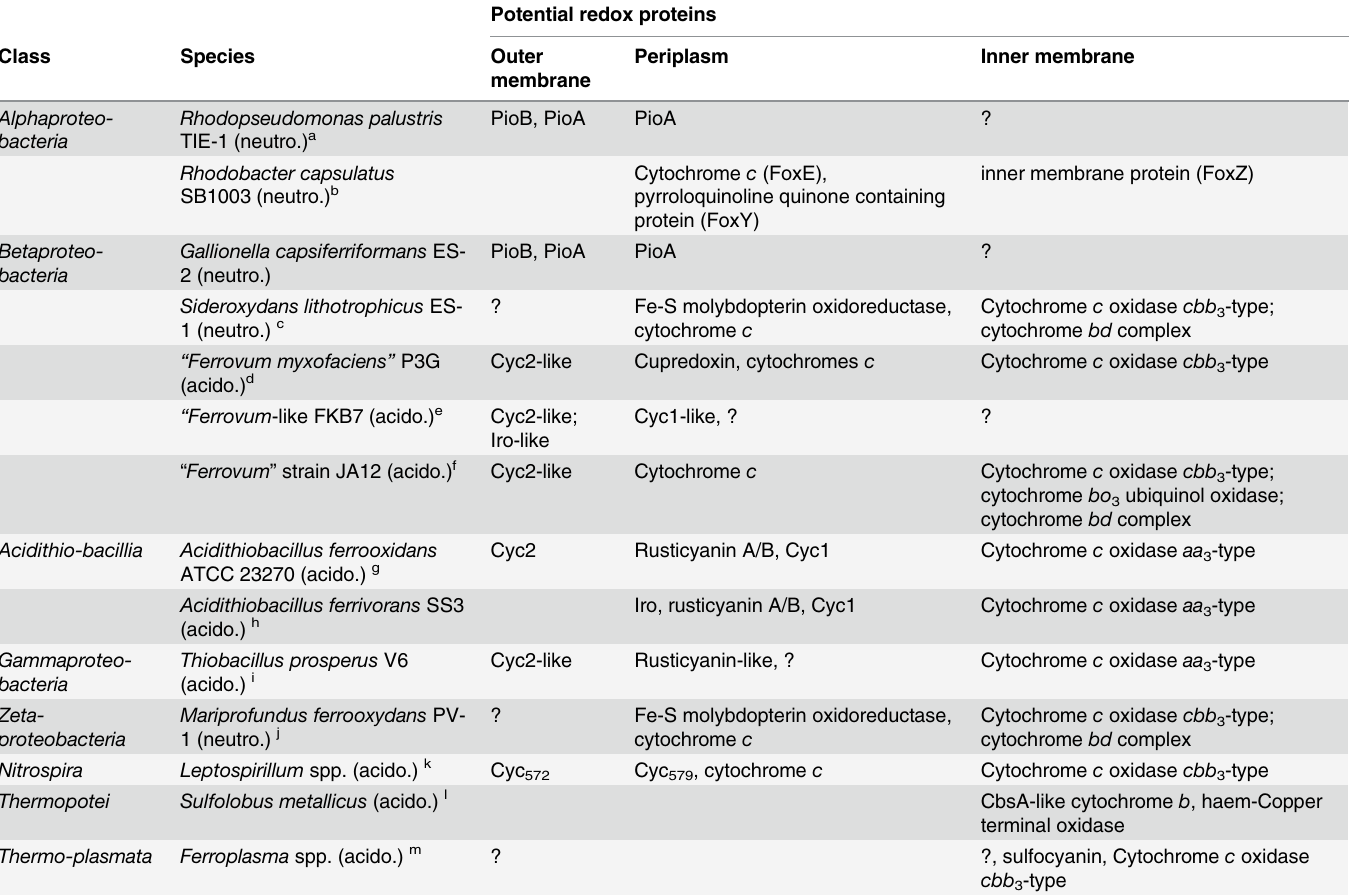
Table 2. Redox proteins of the ferrous iron oxidation in “ Ferrovum ” strain JA12 and other iron